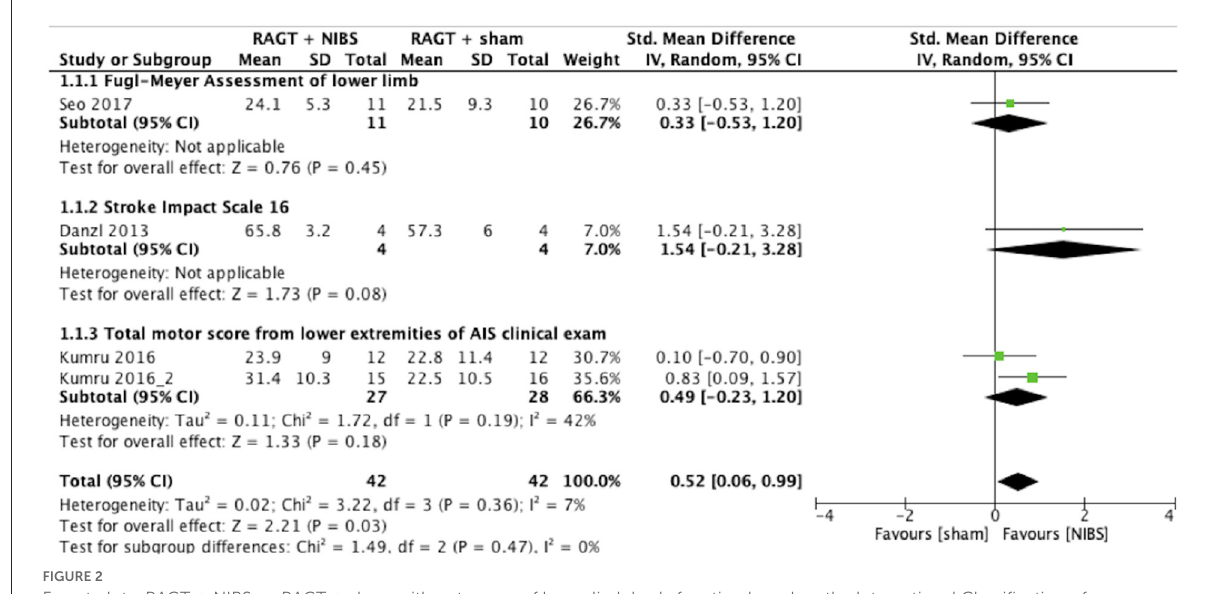
FIGURE2 Forest plots: RAGT + NIBS vs. RAGT + sham with outcomes of lower limb body function based on the International Classification of Functioning, Disability, and Health. AIS, American Spinal Injury Association Impairment Scale; NIBS, non-invasive brain stimulation; RAGT, robot assisted gait training.